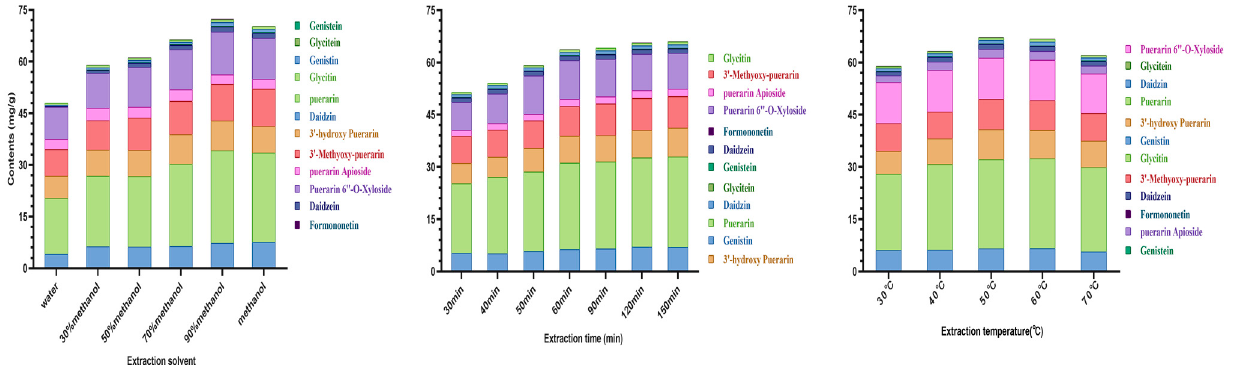
Figure 3. Effect of extraction solvent, temperature, and time on the concentration of isoflavones in pueraria extracts.